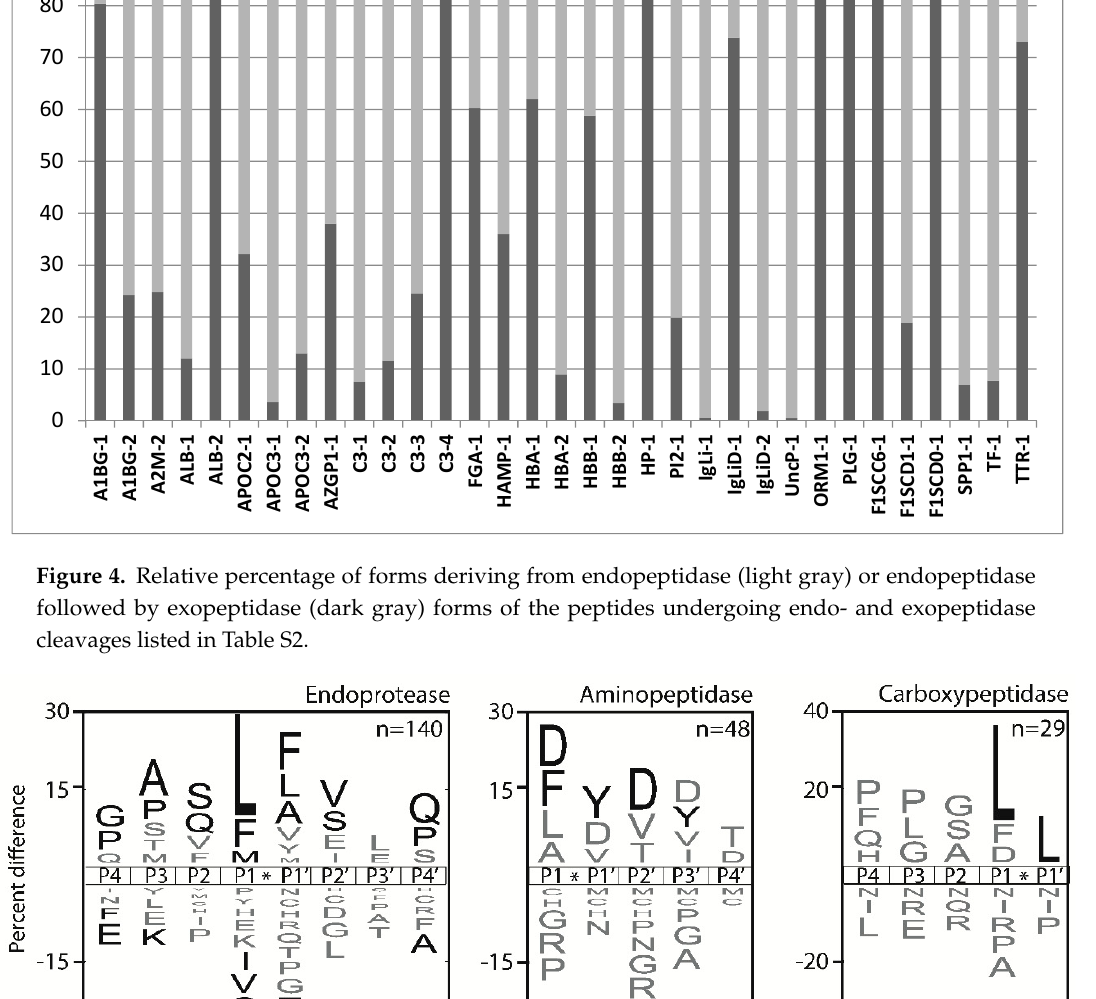
Figure 5. Substrate specificity pattern of pig plasma samples determined using the shotgun mass spectrometric peptidomic approach. The iceLogo plots [21] represent the amino acid frequency surrounding the endo- and exopeptidase cleavage sites using the sequences of non-redundant cleavages (Table S2). Residues shown in black are significantly ( p < 0.05) increased in frequency while residues in gray have p > 0.05. Lowercase n corresponds to norleucine while the number of cleavage sites used to make the iceLogo plots are indicated in the bottom right corner of each panel.